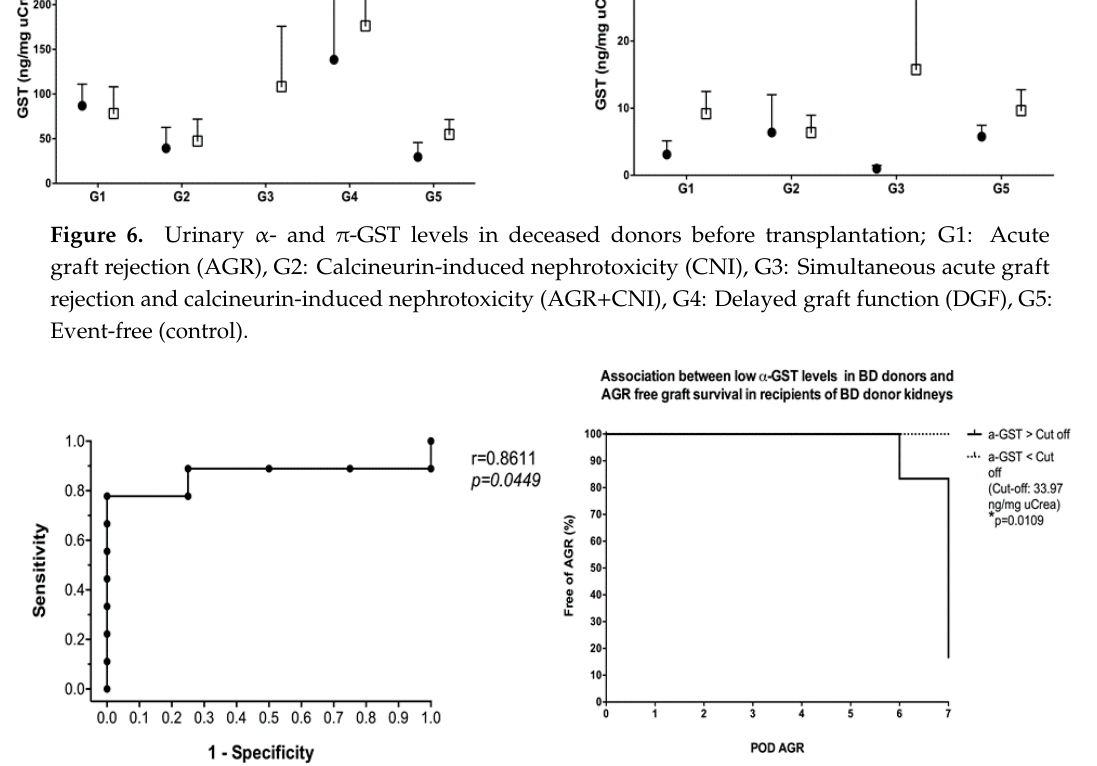
Figure 7. Correlation between urinary α -GST levels in brain-dead donors before transplantation and probability of graft survival without acute graft rejection in corresponding recipients during the first week after transplantation.